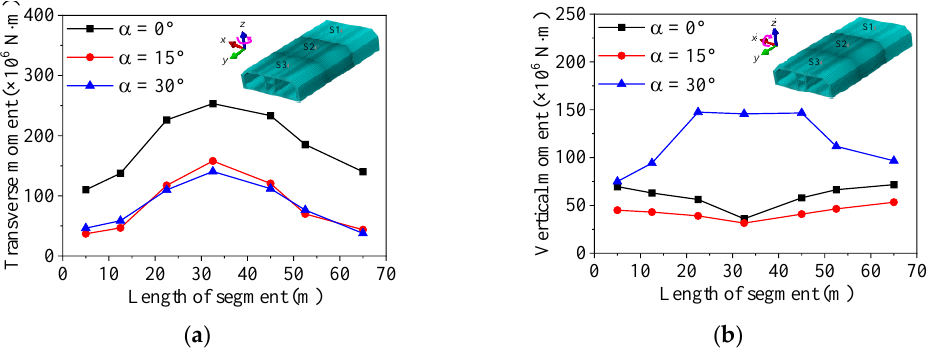
Figure 19. Curves of bending moment of segment at different angles of incidence: ( a ) transverse; ( b ) vertical.